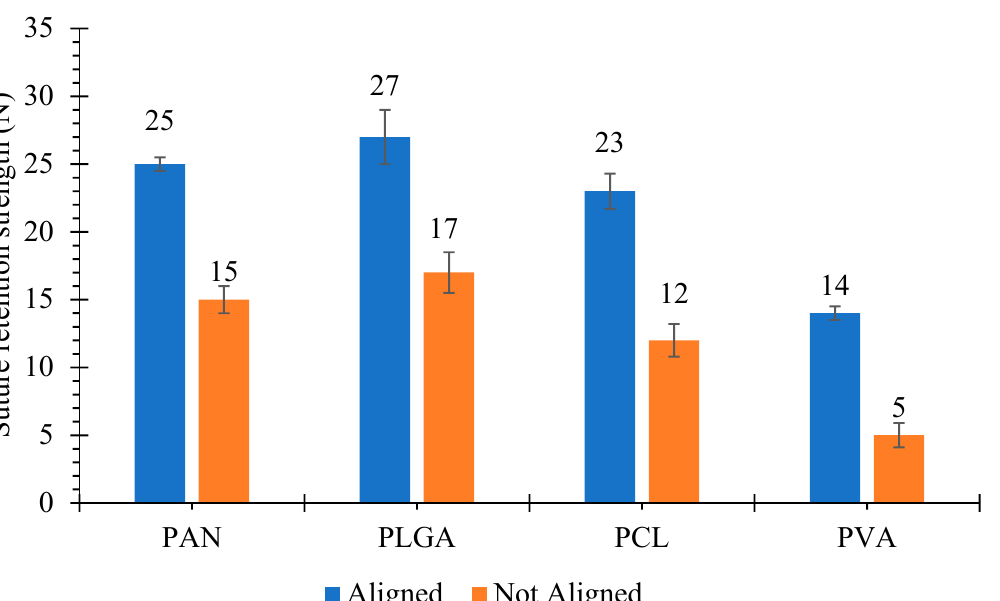
Figure 5. Suture retention strength of cylindrical nanofibrous structures, with ‘aligned’ and ‘not aligned’ fibers. In each graft type, five samples were analyzed and mean values of suture retention strength were recorded. In the cases of aligned scaffolds, PLGA had the highest suture retention strength with a value of 27 ± 2 N, whereas PVA had the lowest suture retention strength of 14 ± 0.5 N. Suture retention strength values of aligned PCL and PAN